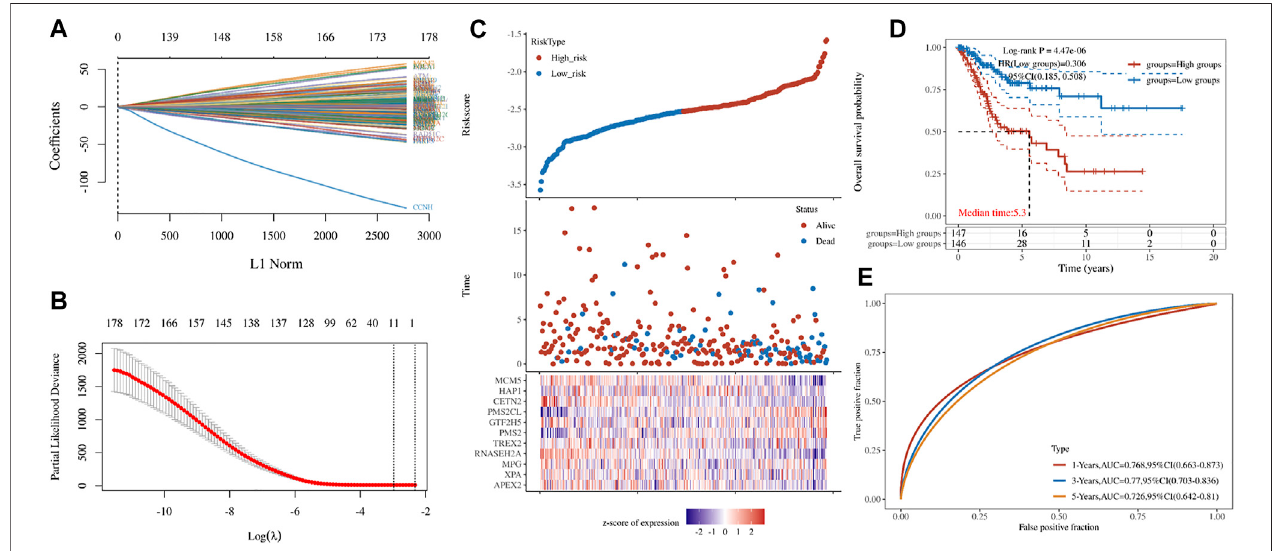
FIGURE 3 | Key genes. (A,B) LASSO Cox regression model (C) Cervical cancer patients grouped according to Riskscore (D) The K-M curve for the different groups of Riskscore (E) The ROC of model of Riskscore in